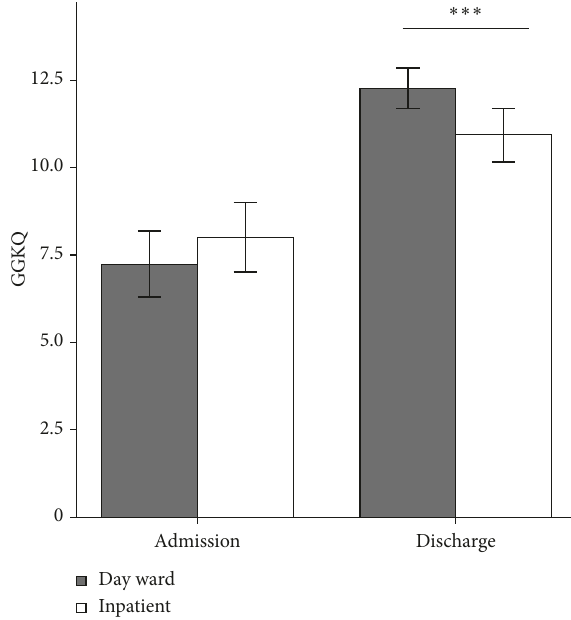
Figure 4: Comparison of glaucoma knowledge between the 2 groups. GGKQ, Gray Glaucoma Knowledge Questionnaire. ∗∗∗ P < 0 . 001. Error bars: 95% confidence